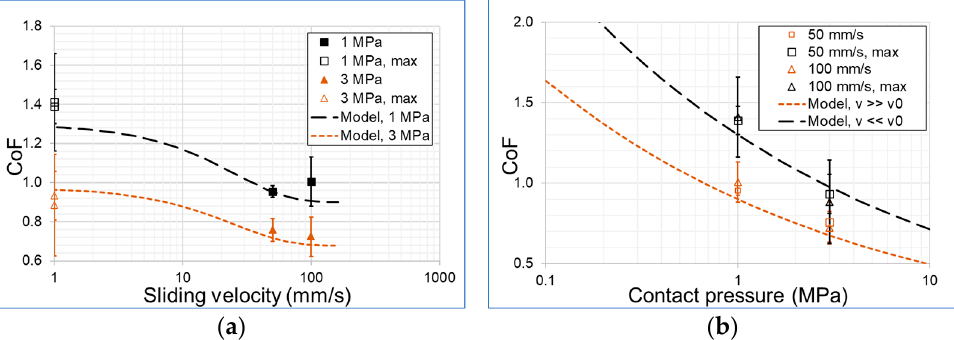
Figure 14. Model fit for frictional model for ( a ) sliding velocity and ( b ) contact pressure vs coefficient